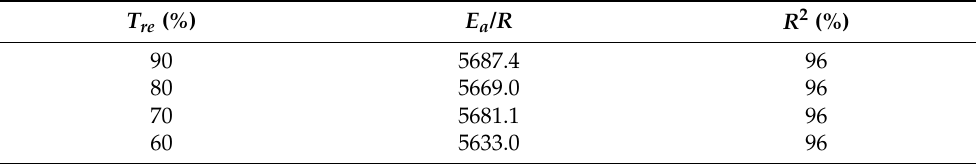
Table 6. Values of E a / R (G1) based on the second prediction model.